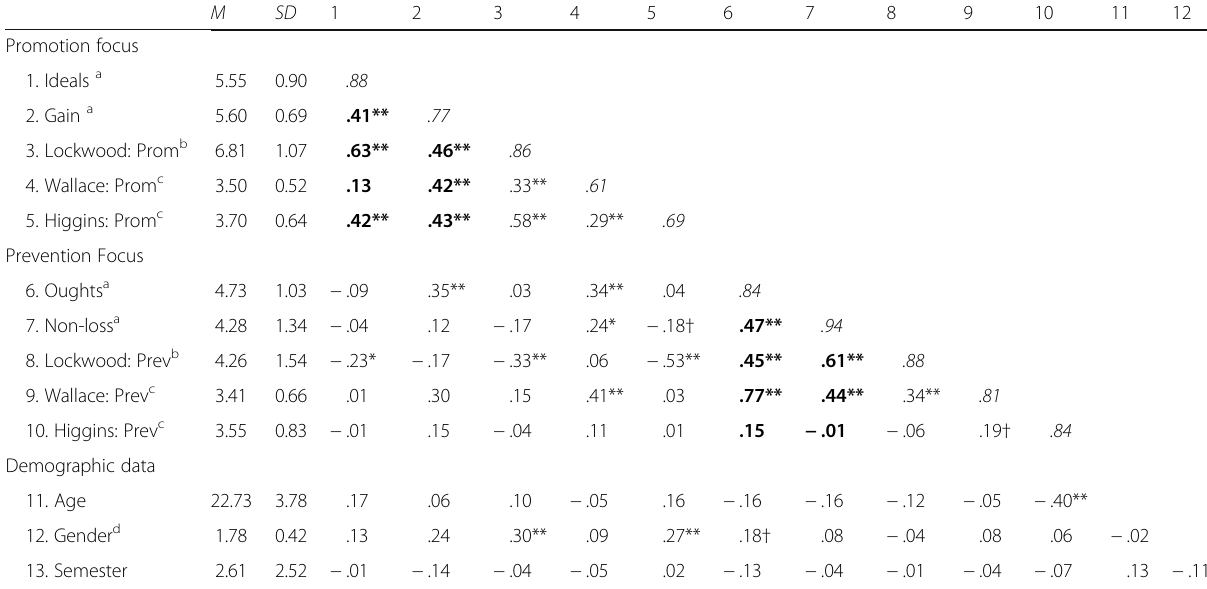
Table 4 Means, standard deviations, correlations, and internal consistencies of the new and existing RF measures (study 3) M